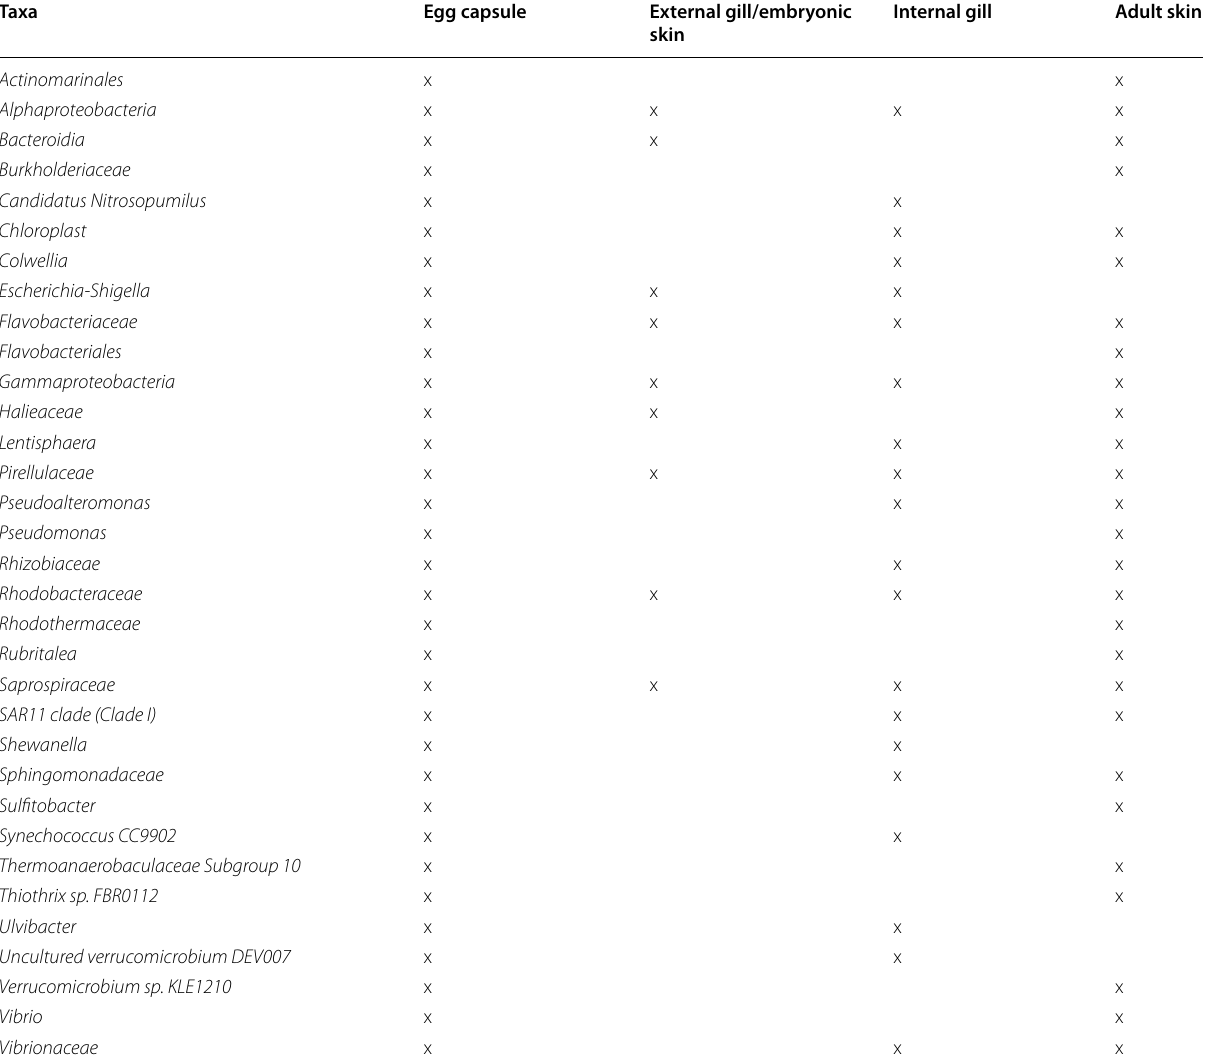
Table 1 Core taxonomic units shared between tissues